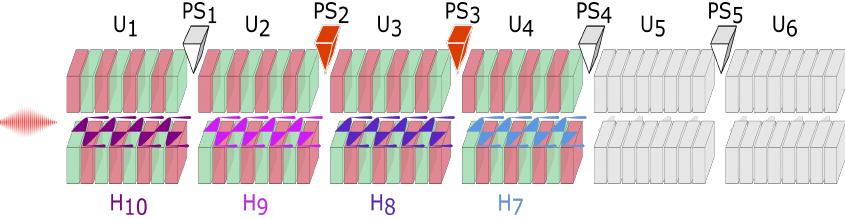
Figure 4. Undulator configuration for the four harmonics’ generation. Each harmonic is generated using one undulator. H 10 is generated by the undulator U 1 ; H 9 is generated by the undulator U 2 ; H 8 is generated by the undulator U 3 ; H 7 is generated by the undulator U 4 . The phase shifters used to conduct a phase scan are indicated in